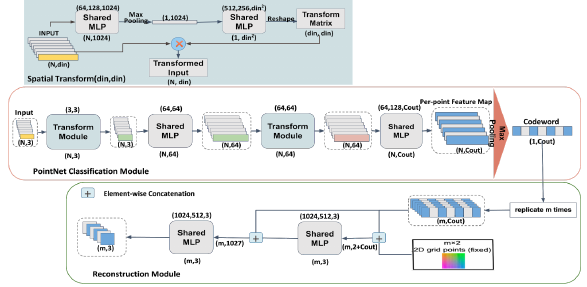
Figure 1: The architecture of our 3D reconstruction.based feature visualization